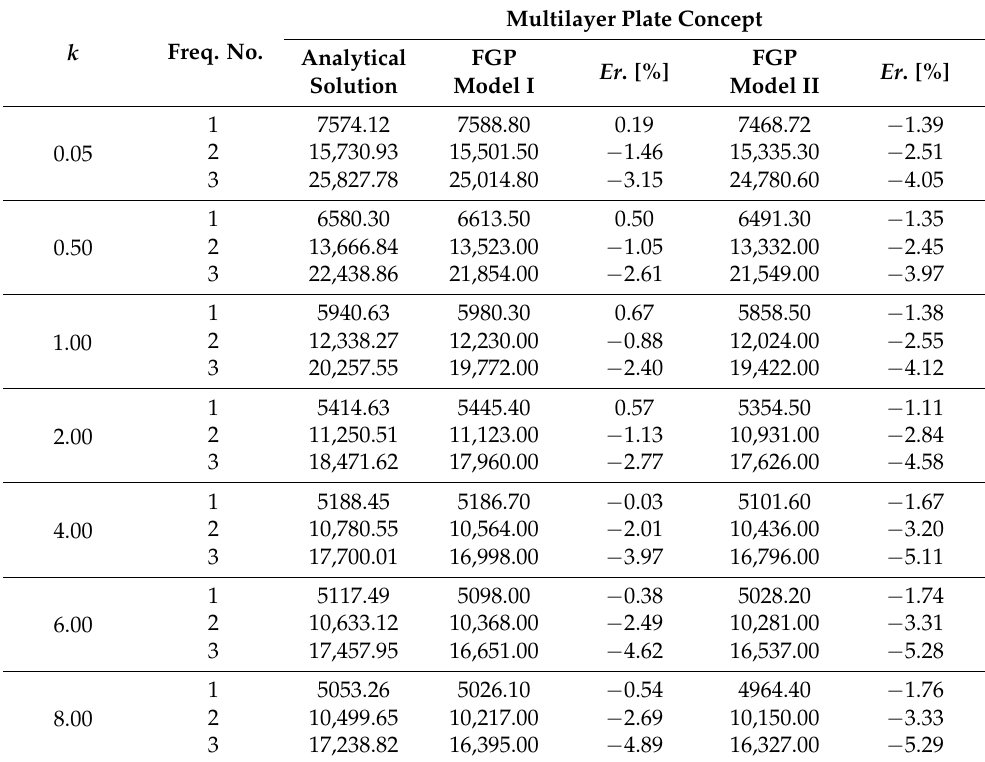
Table 12. Some results regarding natural frequencies [Hz], by FEM calculated.